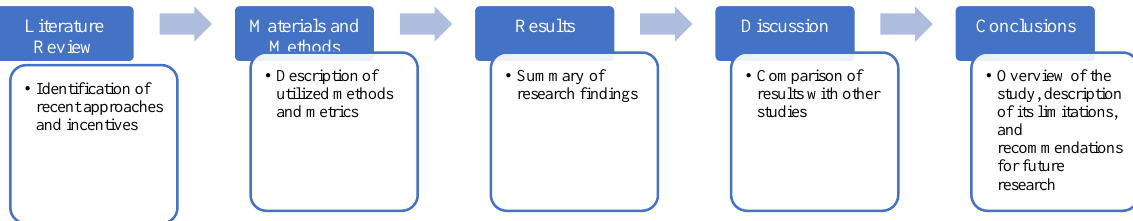
Figure 1. Structure of the article. Source: own research .